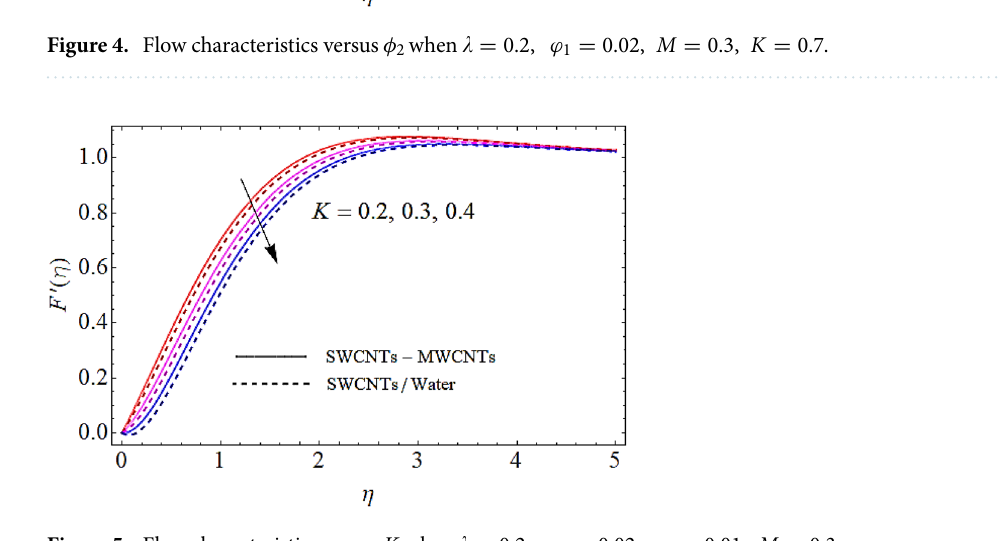
Figure 5. Flow characteristics versus K when (cid:31) = 0.2, ϕ 1 = 0.02, ϕ 2 = 0.01, M = 0.3